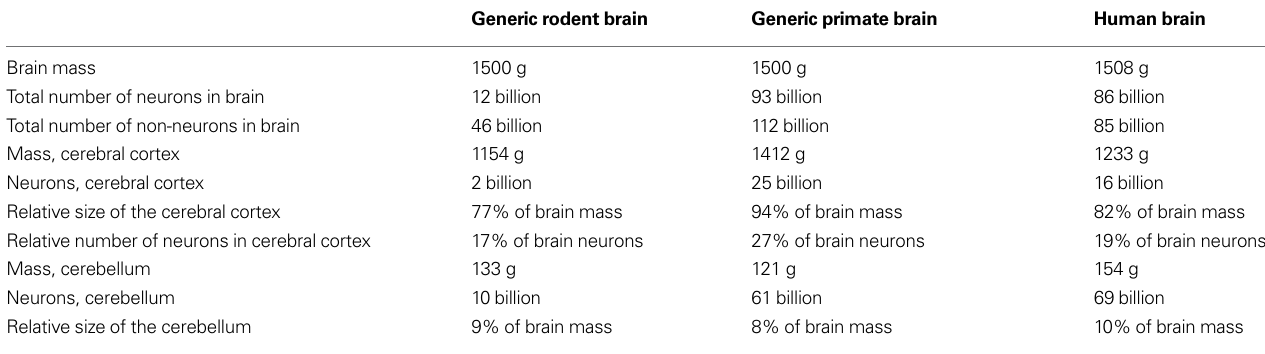
Table 2 | Expected values for a generic rodent and primate brains of 1.5 kg, and values observed for the human brain (Azevedo et al., 2009) . Generic rodent